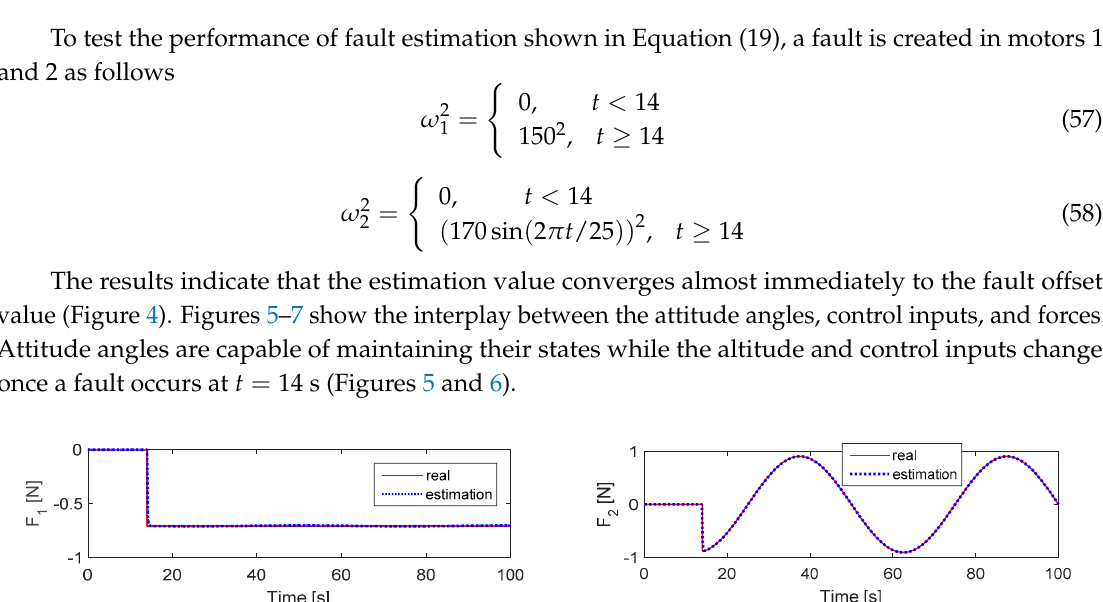
Figure 4. Fault estimation in the presence of white noise: ( a ) F 1 fault offset and ( b ) F 2 fault